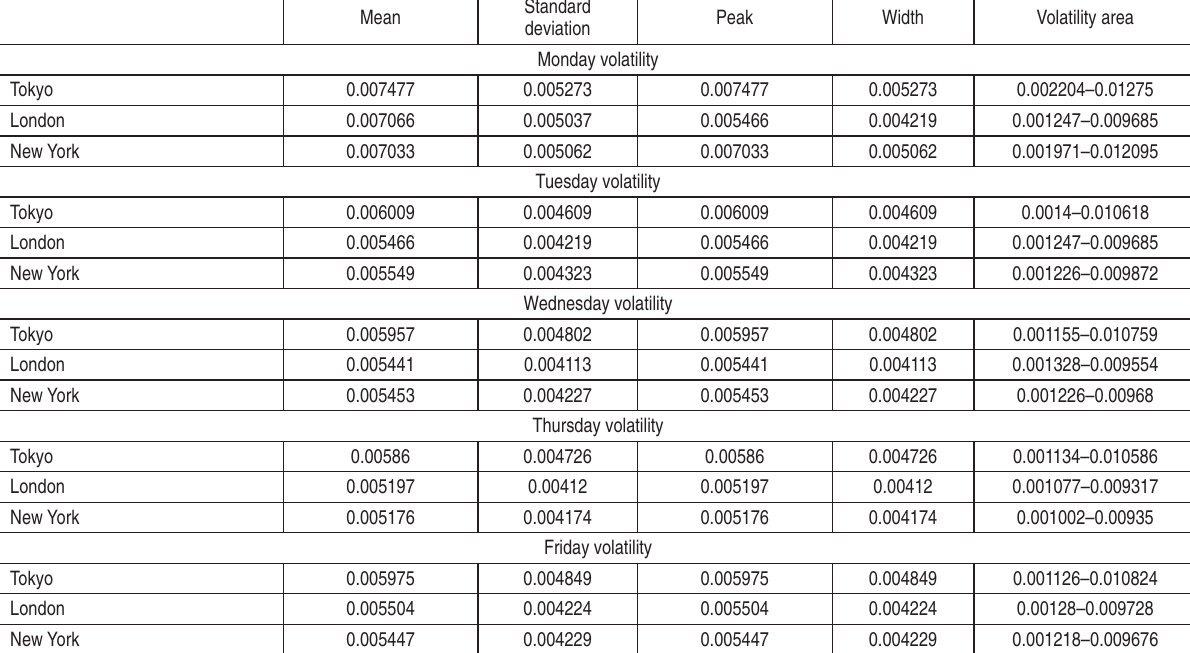
Table 6. Estimated coefficients of the volatility of the log-normal function in Tokyo, London and New